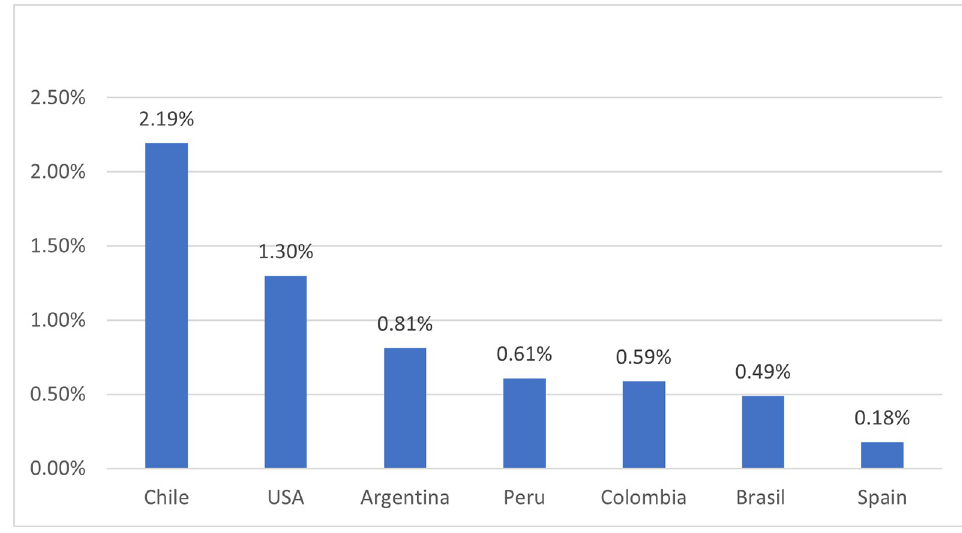
Fig 2. COVID monetary subsidy (%de PBI). Source: Central Banks